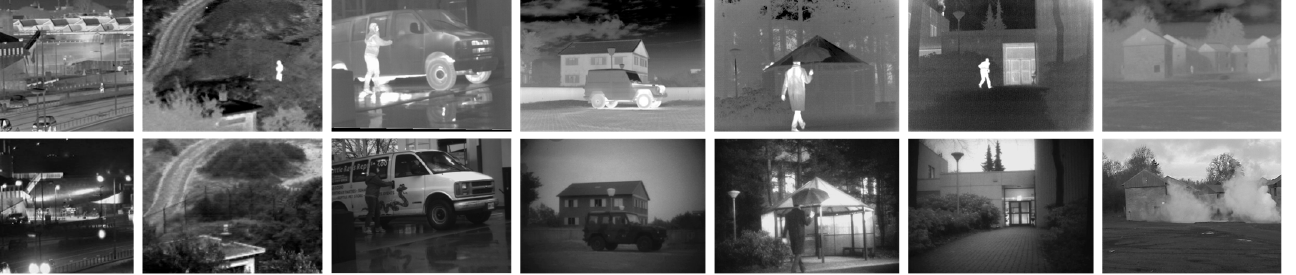
Figure 6. Seven pairs of input images. The first row consists of infrared images, and the bottom row contains visual images. From left to right are Road, Camp, Car, Marne, Umbrella, Kaptein and Octec. Among them, “Road” is a set of images taken under the low illumination condition.